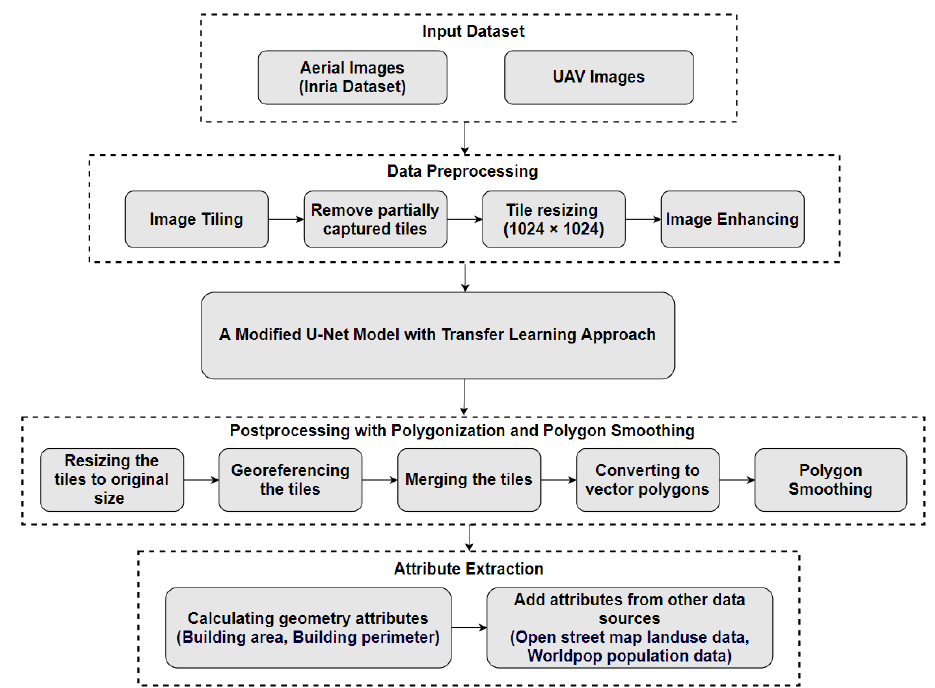
Figure 1. Diagram for the proposed methodology.